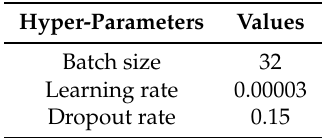
Table 11. Hyper-parameters used for transformer models from Table